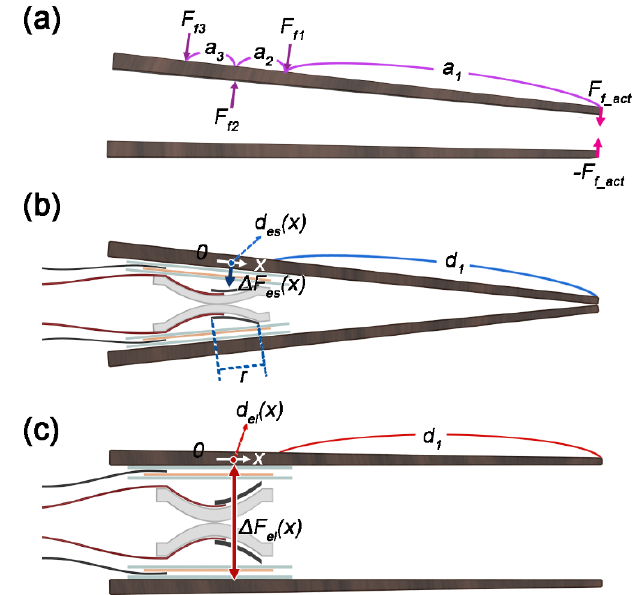
Figure 5. Schematics for the chopstick robot operation: ( a ) the force acting when moving the chopsticks with fingers (Chepisheva et al.’s theory), ( b ) the chopsticks are closed by electrostatic force, and ( c ) the chopsticks are opened by elasticity.